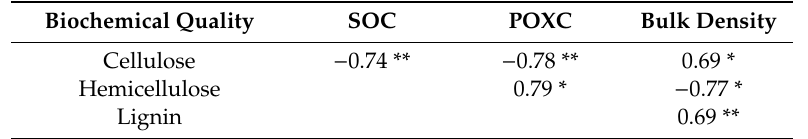
Table 5. Correlation between biochemical qualities and certain soil properties (* p < 0.05, ** p < 0.01). Biochemical Quality SOC POXC Bulk